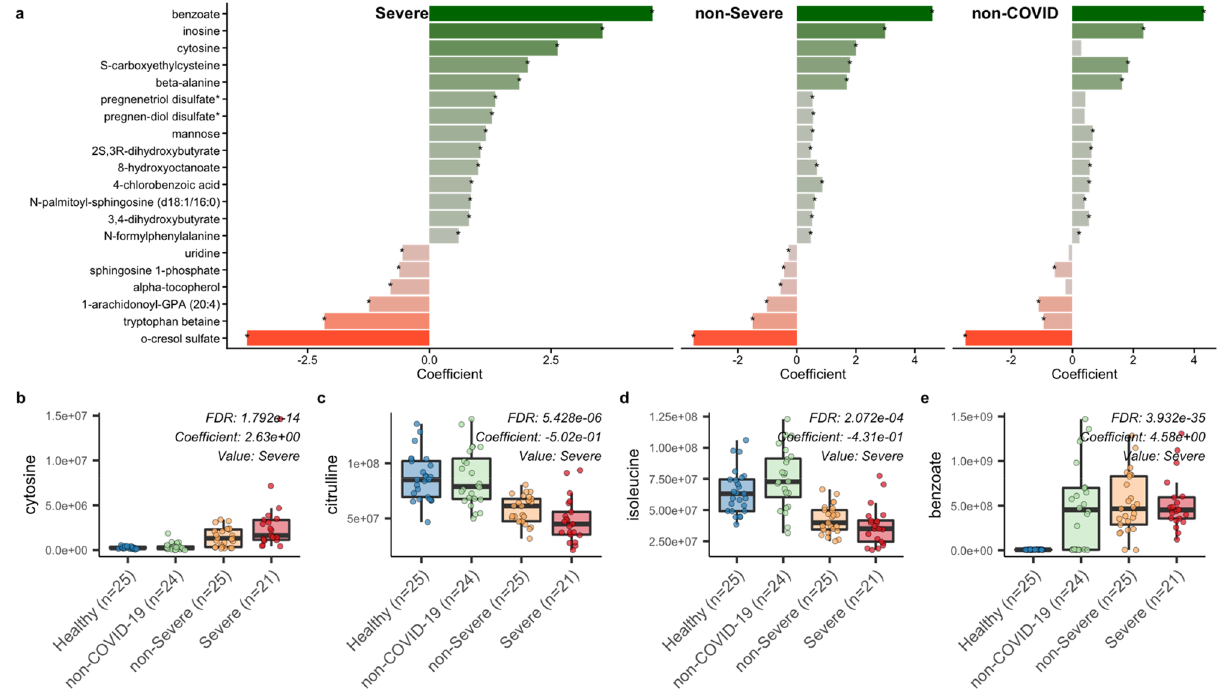
Figure 3. metabolite changes in COVID-19. ( a ) 20 most significant metabolites with lowest q-value (FDR) in comparison of severe group vs. healthy group are shown. Then, the corresponding changes in non-severe and non-COVID-19 for the same metabolites are shown. ( b , c , d , e ) show different patterns we observed among these associations. For example, Cytosine has a higher level in COVID-19 groups vs. non-COVID-19 and has been shown that it can play a biomarker for COVID-19 diagnostics.